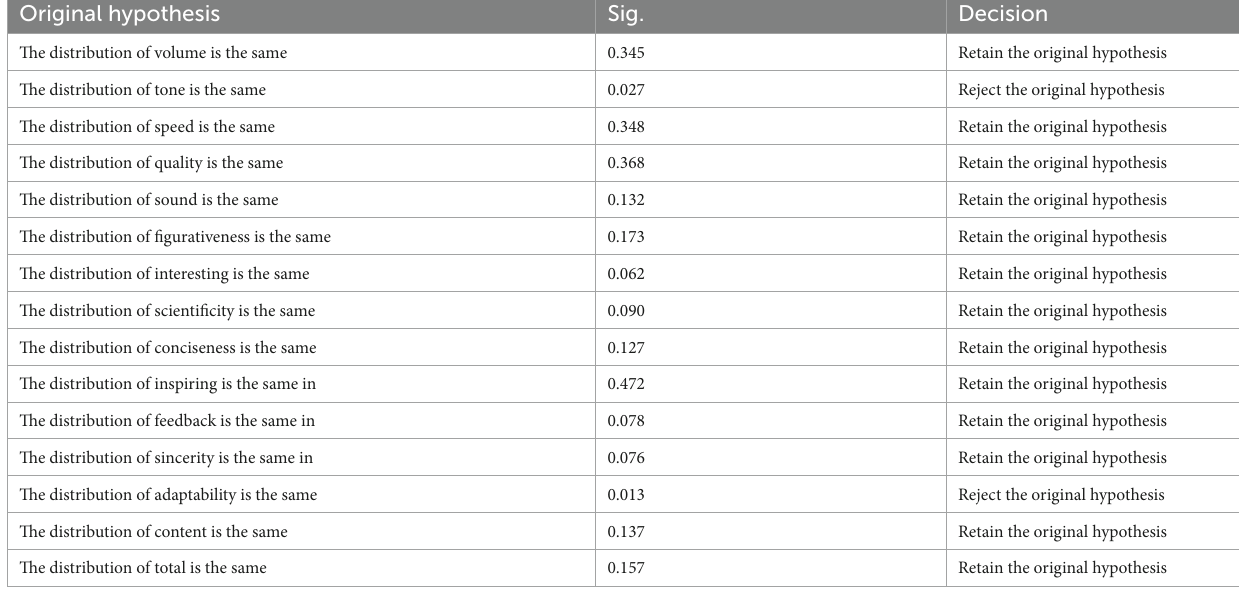
TABLE 10 Kruskal-Wallis test for independent samples (expert, skilled, and novice teachers). Original hypothesis